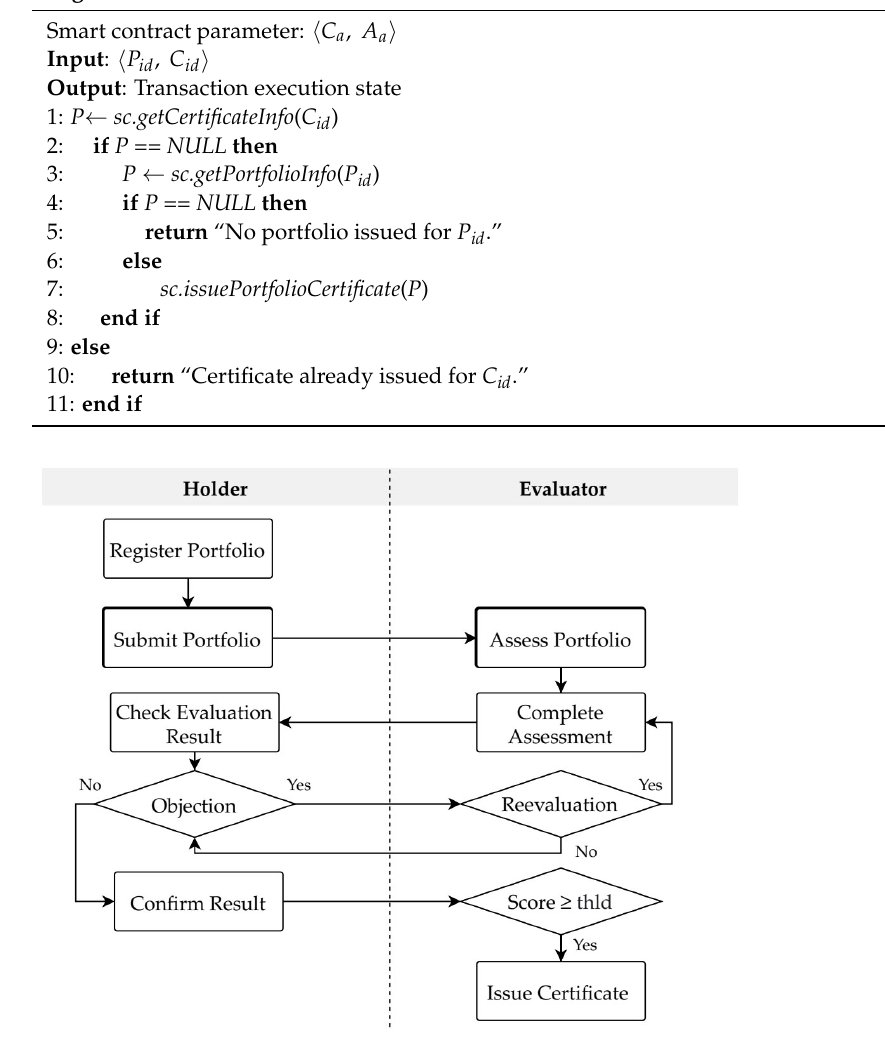
Algorithm 4. E-certificate issuance